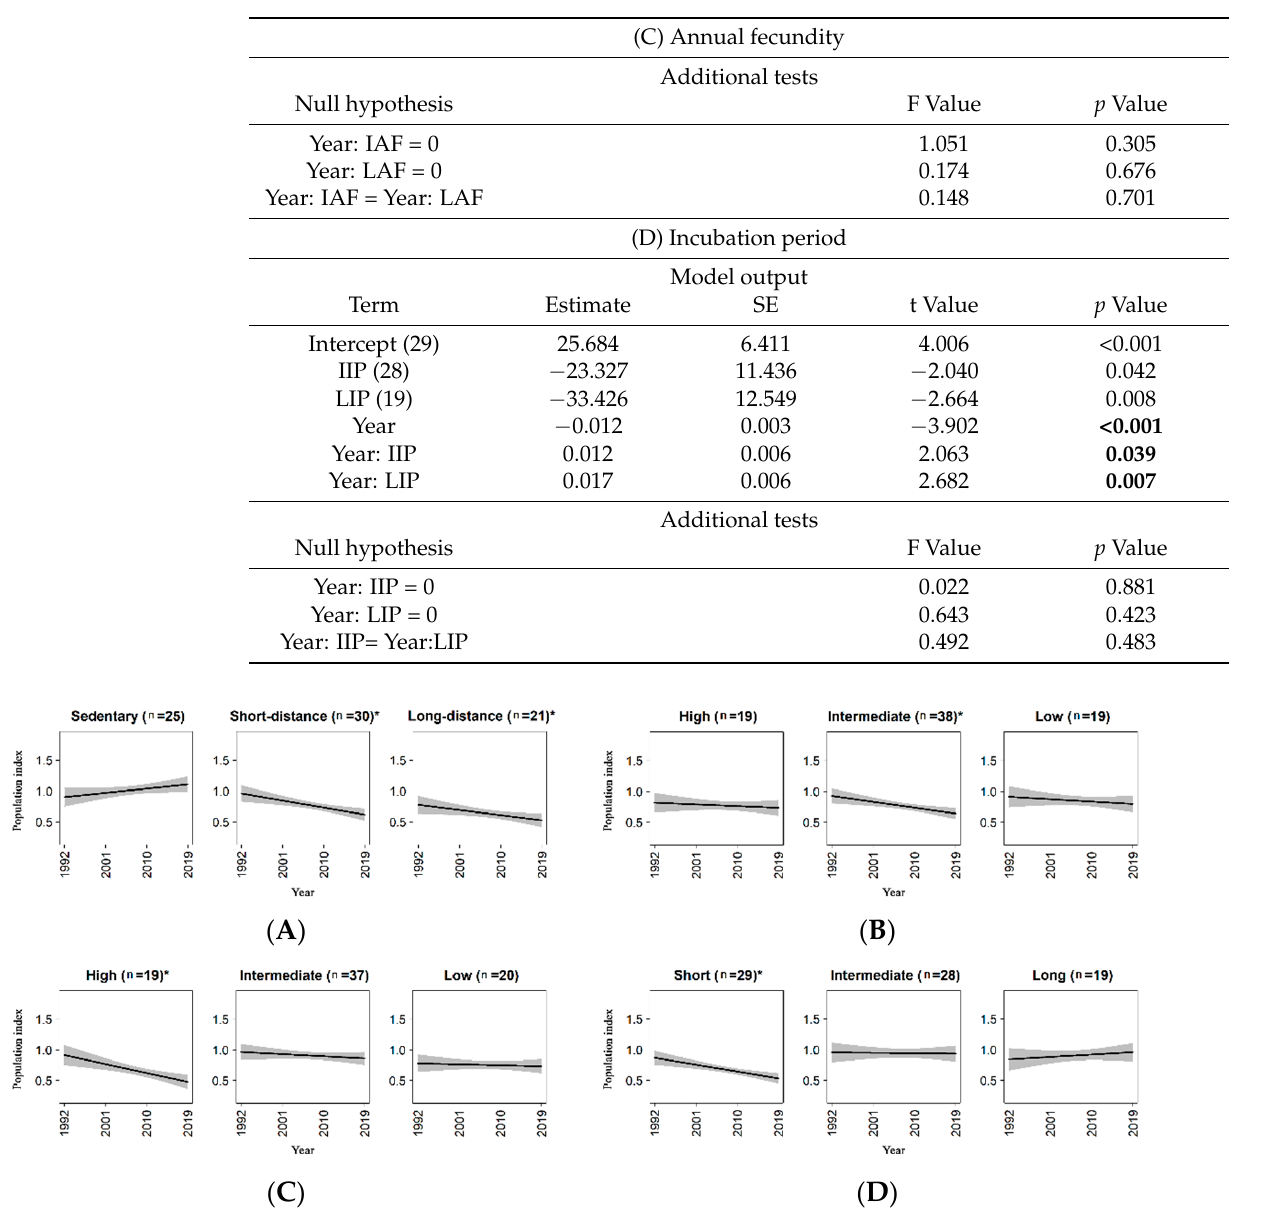
Figure 2. Population trends for bird species grouped according to the life history traits. ( A ) Migration strategy; ( B ) dispersal ratio; ( C ) annual fecundity; ( D ) incubation period. Y-axis represents the population index of the species (see Section 2.4.2 for details). Shaded area represents the 95% confidence interval of the regression line. The number of species in each group is shown in parentheses. The asterisk indicates the significance of the trend in relation to non-zero slope.